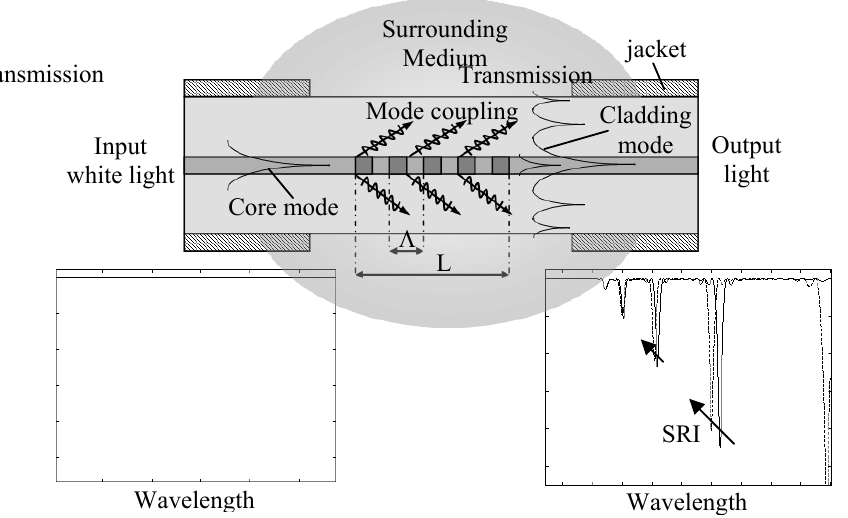
Figure 19. Pictorial description of mode coupling in LPGs and spectral dependence on SRI (not to